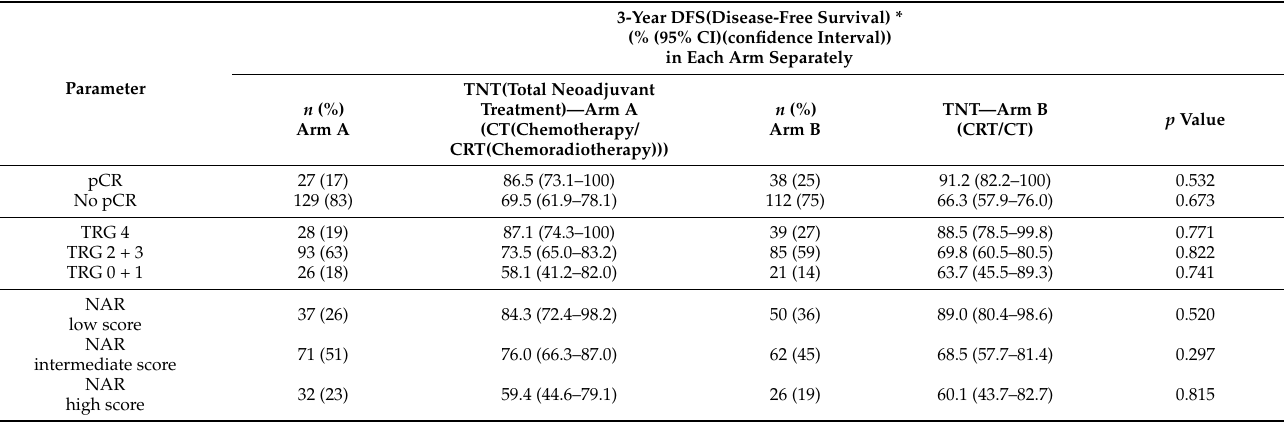
Table 3. Prognostic impact of each subgroup of pCR, TRG and NAR score on disease-free survival.